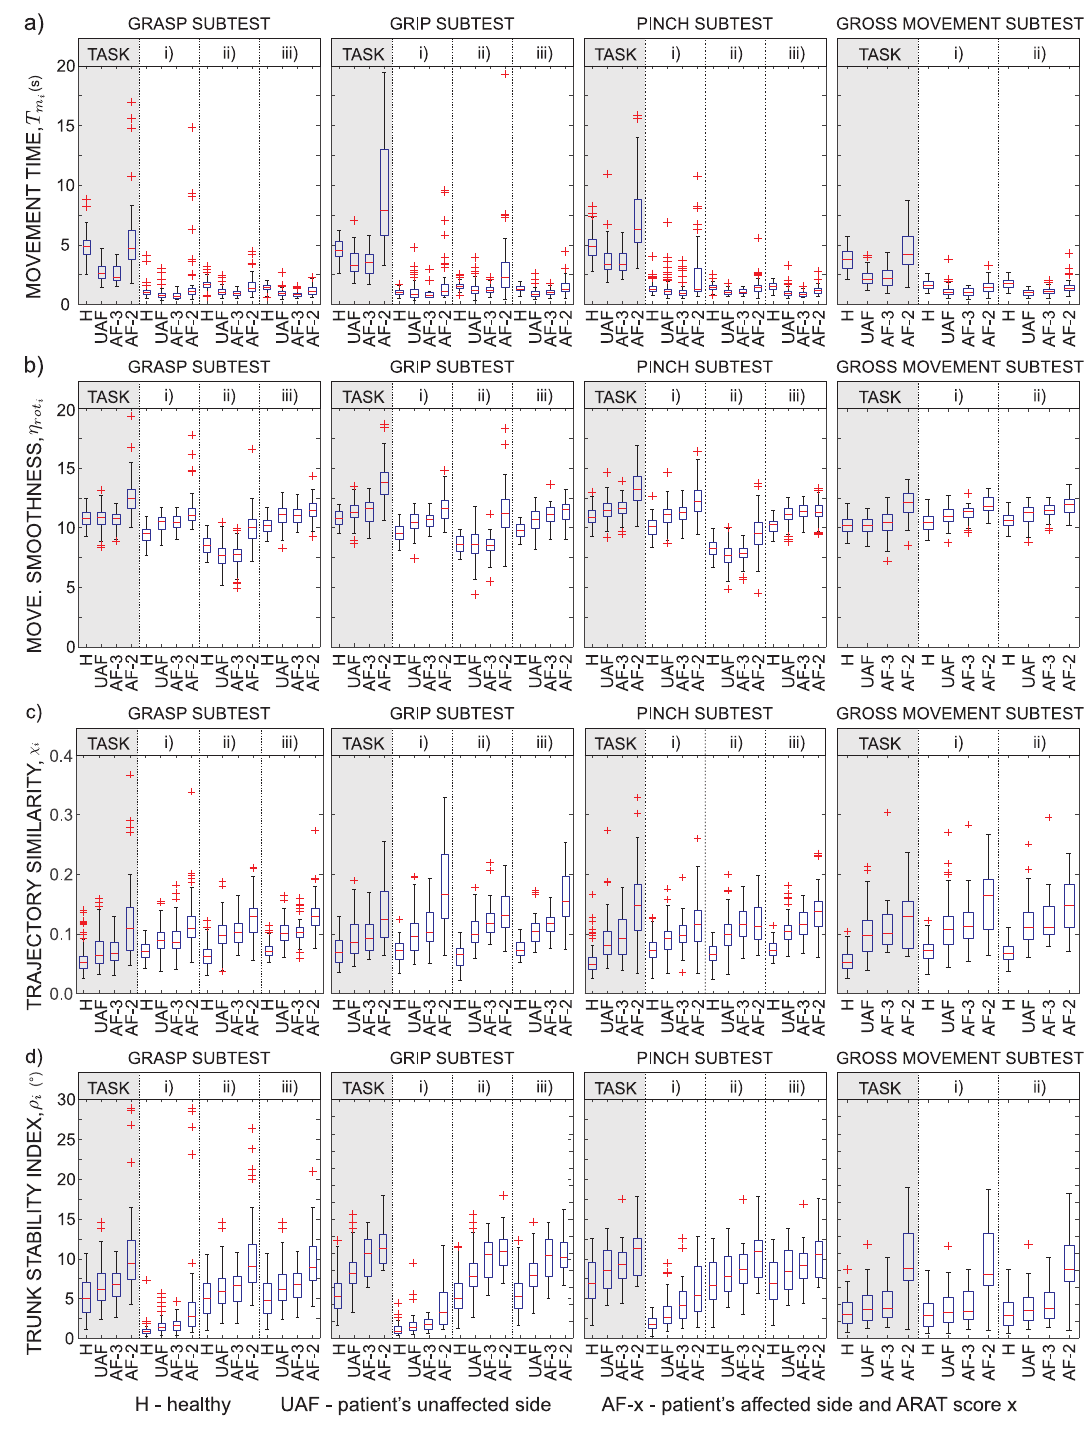
Figure 5. Quantification of movement during ARAT tasks execution. Parameters for movement analysis: ( a ) movement time T m ; ( b ) movement smoothness represented as rotational jerk index η rot i ( c ) trajectory similarity χ i ; and ( d ) trunk stability index ρ i . Quantities are presented for the task (grey area): (i) reach to grasp phase; (ii) transfer phase; and (iii) return phase. Presented tasks from left to right are: (1) grasp subtest (different blocks, cricket ball, sharpening stone); (2) grip subtest (different alloy tubes and washer); (3) pinch subtest (marbles, bearing balls); and (4) gross movement subtest. Presented groups are: H, healthy; UAF, patient’s unaffected side; and AF- x , patient’s affected side and Score x